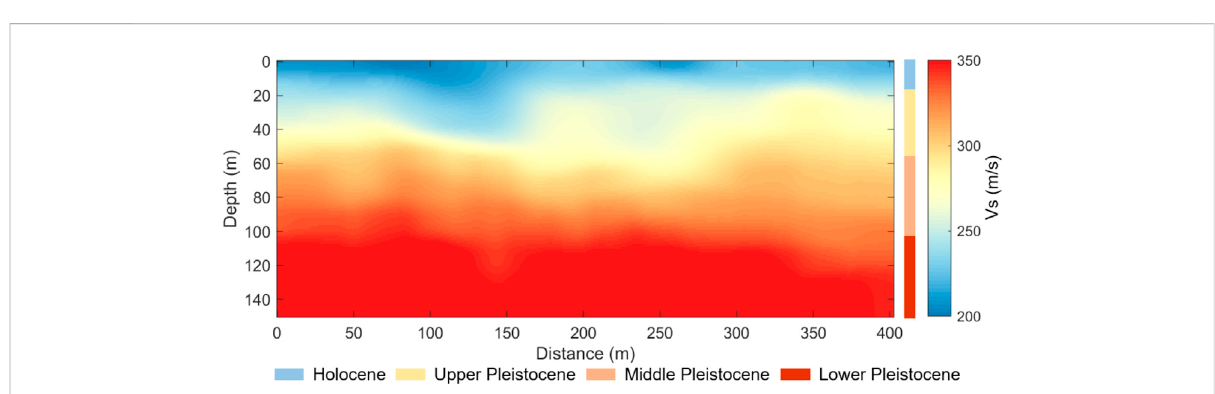
FIGURE 11 The 2D shear wave velocity pro fi le along the DAS line. The color bar indicates the depths of key horizons according to the prior geological information in the study area.